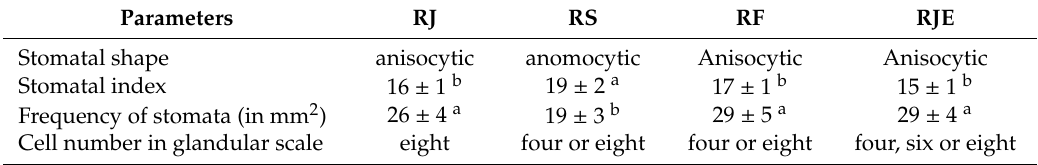
Figure 1. Photomicroscopic data of the leaf surface from four Reynoutria plants: ( a ) adaxial (above) surface of the leaf; ( b ) abaxial (lower) surface of the leaf. The black bars mean 100 µ m. st : stomata; gs : glandular scale. Table 1. Anatomical characteristics of the lower leaf surface of Reynoutria plants.